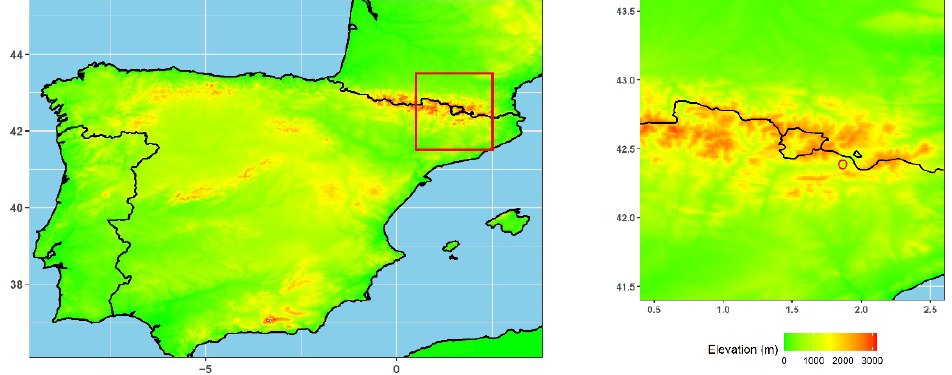
Figure 1. Measurement location at the Das aerodrome in northeast Spain. The aerodrome location (1100 m a.s.l.) is marked with a red circle in the right panel.